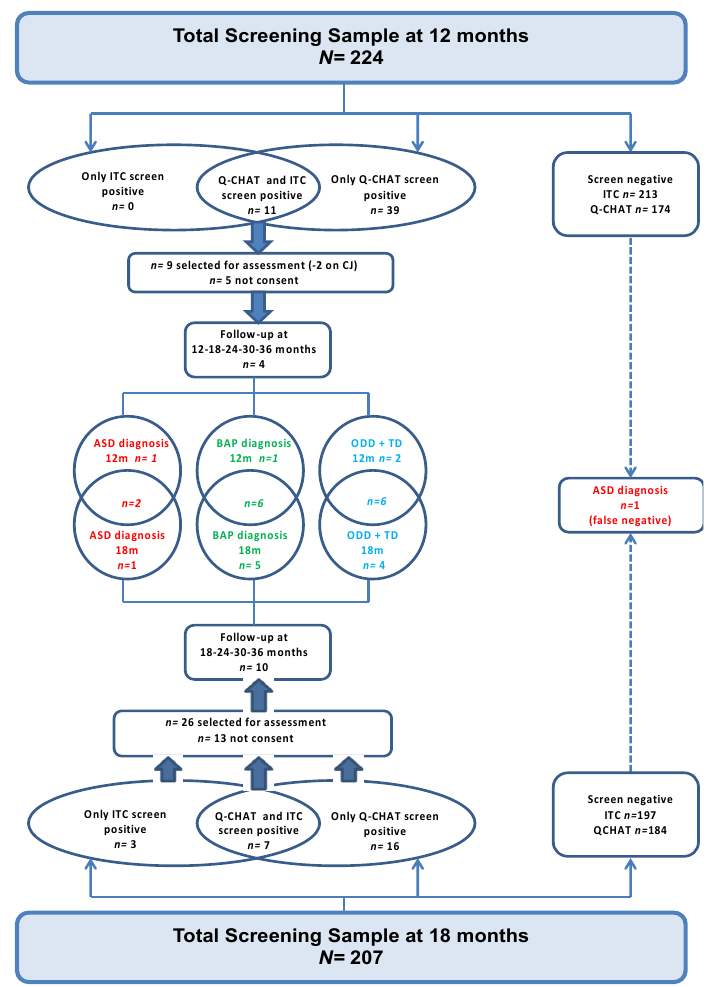
Figure 1. Flowchart of the project design. Project design. Two-stage screening approach at 12 and 18 months applied to the same sample. The intersections in the middle represent the children classified as autism spectrum disorder (ASD) ( n = 2), broader autism phenotype (BAP) ( n = 6), Other non-spectrum developmental disorders (ODD) + typical development (TD) ( n = 5) at the final outcome of 36 months. On the right the only false-negative case diagnosed as ASD at 36 months. I-TC: Infant–Toddler Checklist; Q-CHAT: Quantitative Checklist for Autism in Toddlers.